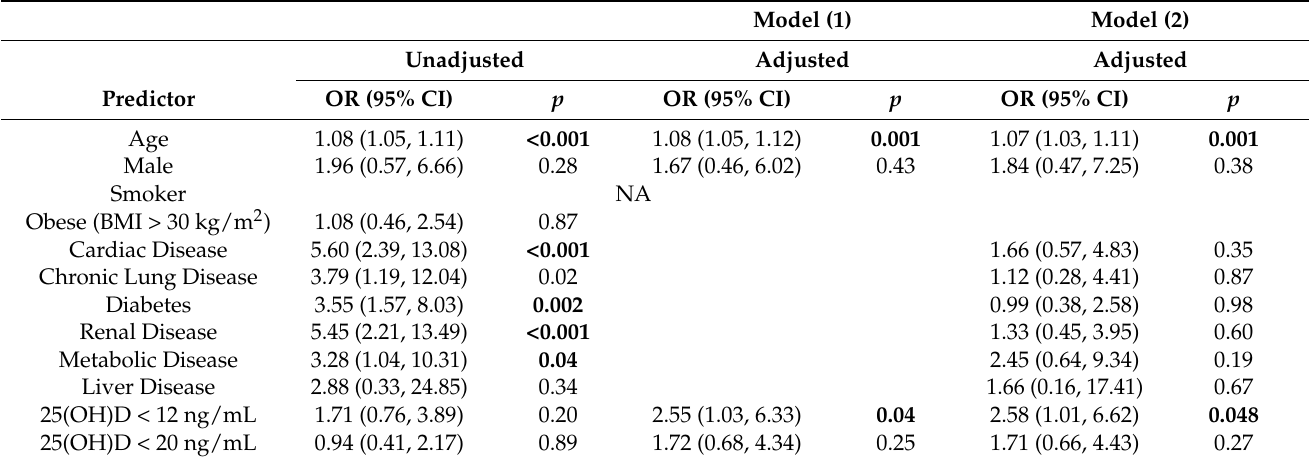
Table 3. Significant predictors of mortality, using binary logistic regression